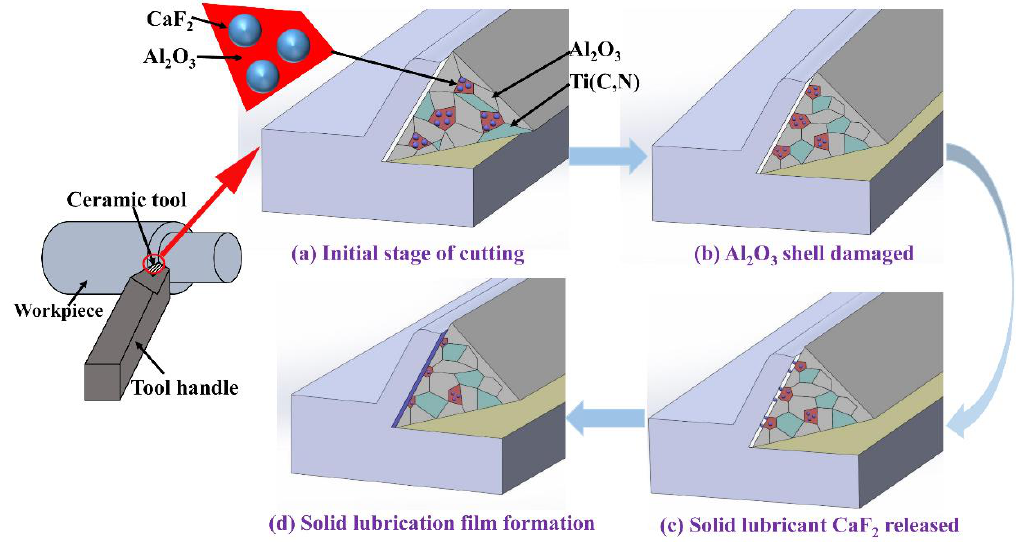
Figure 10. Schematic diagram of solid lubricating film formation process of the ceramic tool with CaF 2 @Al 2 O 3 added: ( a ) initial stage of cutting, ( b )Al 2 O 3 shell damaged, ( c ) solid lubricant CaF 2 released and ( d ) solid lubricating film formation.